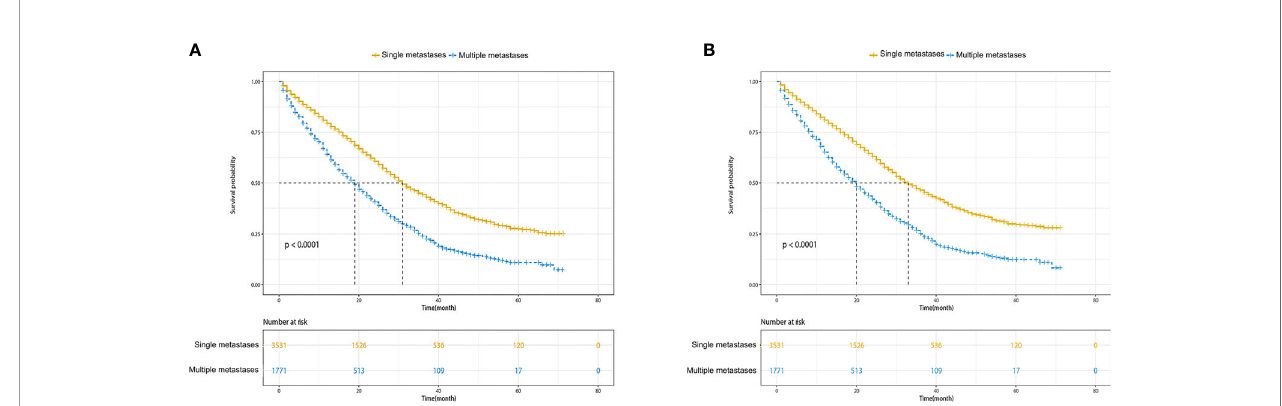
FIGURE 2 | Kaplan – Meier survival curves of survival. (A) Overall survival of single metastases versus multiple metastases. (B) Cancer-speci fi c survival of single metastases versus multiple